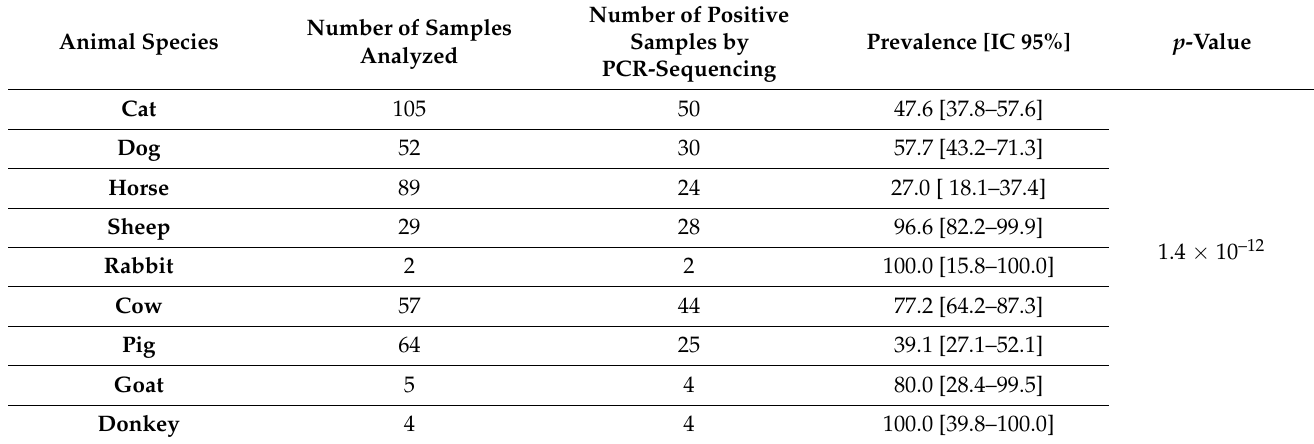
Table 4. Comparison of prevalence based on PCR-sequencing between animal